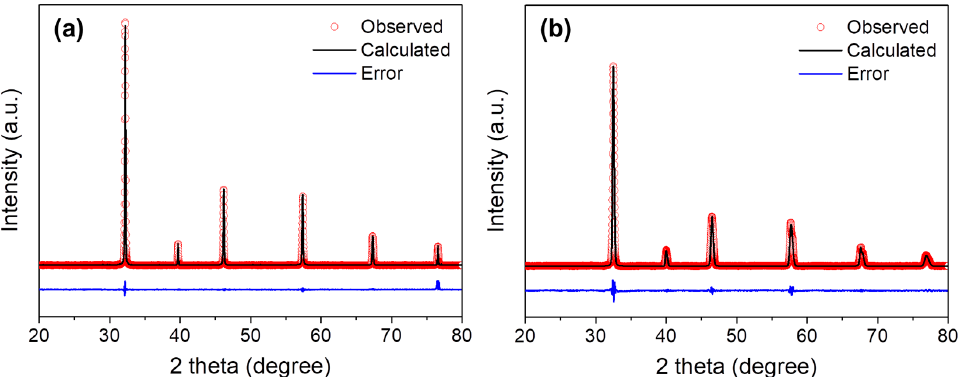
Figure 4. Rietveld refinements of room-temperature XRD patterns of SFMO powders after reduction in pure H 2 at 800 °C for 2 h ( a ) and re-oxidation in air at 800 °C for 2 h ( b ).